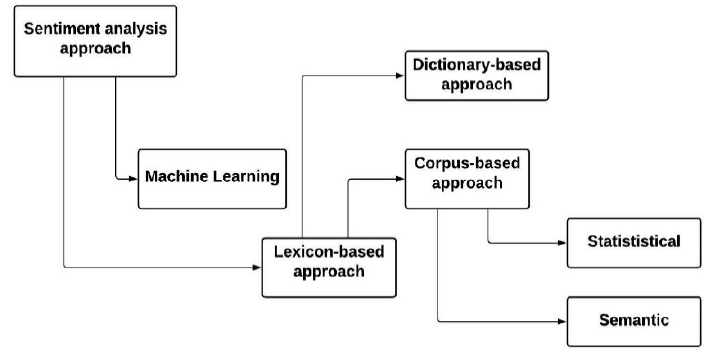
Figure 2. Lexicon-based sentimental analysis architecture for text documents.